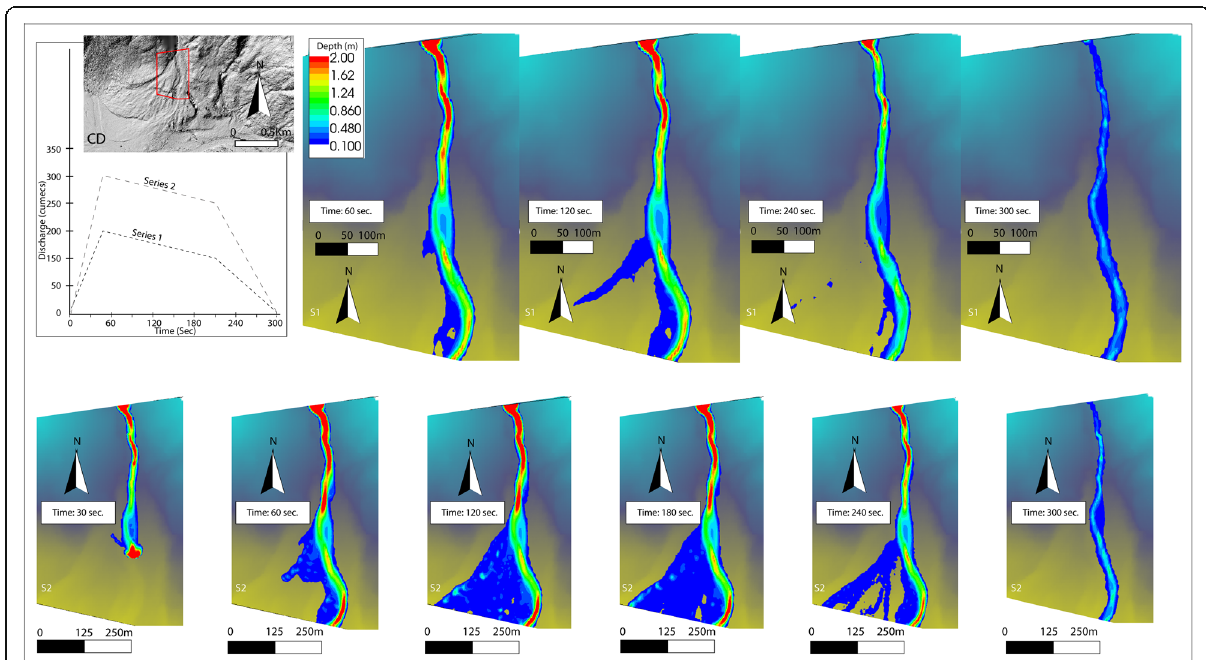
Fig. 6 CFD (computational fluid dynamics) results of catastrophic floodwater release, with two different peaks, showing that in the present fan configuration, the flood water would tend to flow over the true right side of the main channel on the